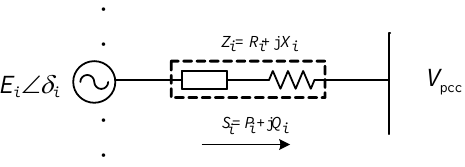
Figure 1. Equivalent circuit of a micro-source.